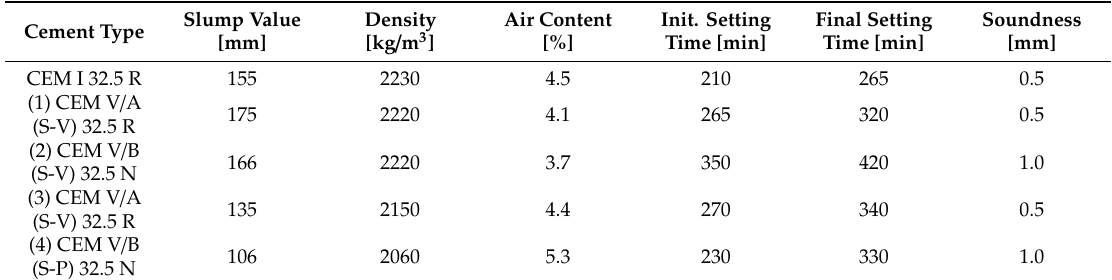
Table 4. Fresh mortar properties of di ff erent CEM V cements.